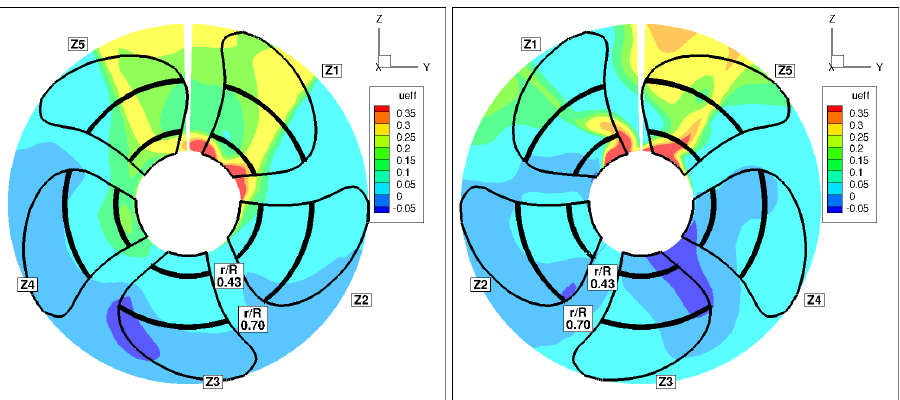
Figure 15. Propulsive performances of the model hull in steady drift motion at 8.4 ◦ , J = 1.12: axial ve- locity defect at the actuator disc inlet section. ( Left ): portside propeller. ( Right ): starboard propeller.